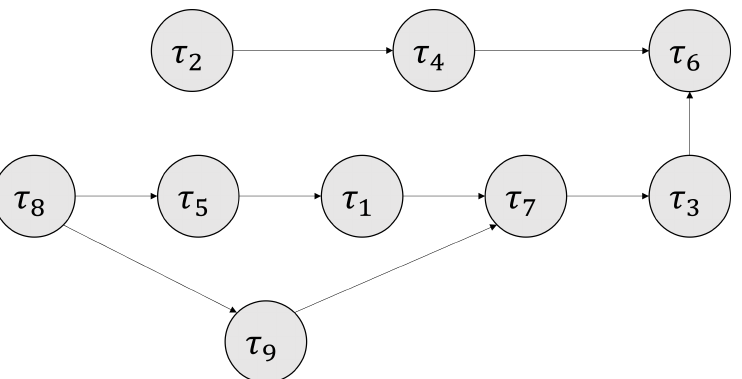
Figure 2. Precedence constraints for task execution.